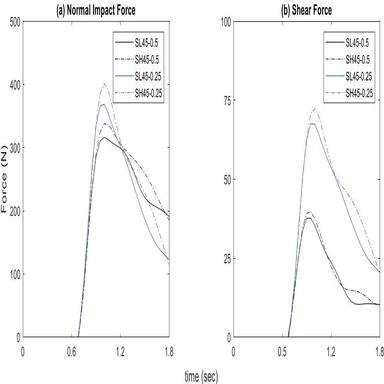
(a), (b) Impact forces on obstacles inducing partial obstruction to the flow, for 45◦ flume angle.